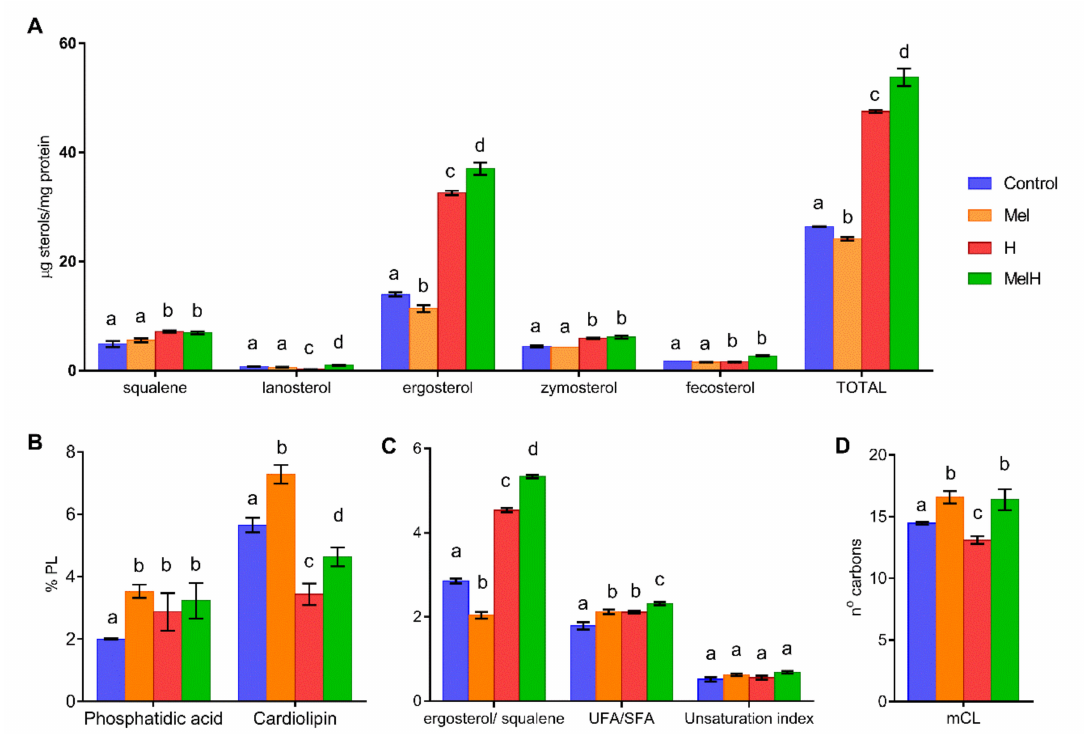
Figure 4. Lipid composition of nonstressed and stressed yeast cells with 2 mM of H 2 O 2 , grown with and without 5 µ M of melatonin (Control, Mel, H, MelH). ( A ) Sterols. ( B ) Phospholipids. ( C ) UFA / SFA ratio (from V á zquez et al. [15]) and unsaturation index defined as follows: [(% C16:1 + % C18:1) + 2 (% C18:2) + 3 (% C18:3)] / 100. ( D ) Medium-chain-length of FA (mCL, from V á zquez et al. [15]). Letters indicate significant di ff erences between lipid concentrations ( p -value <